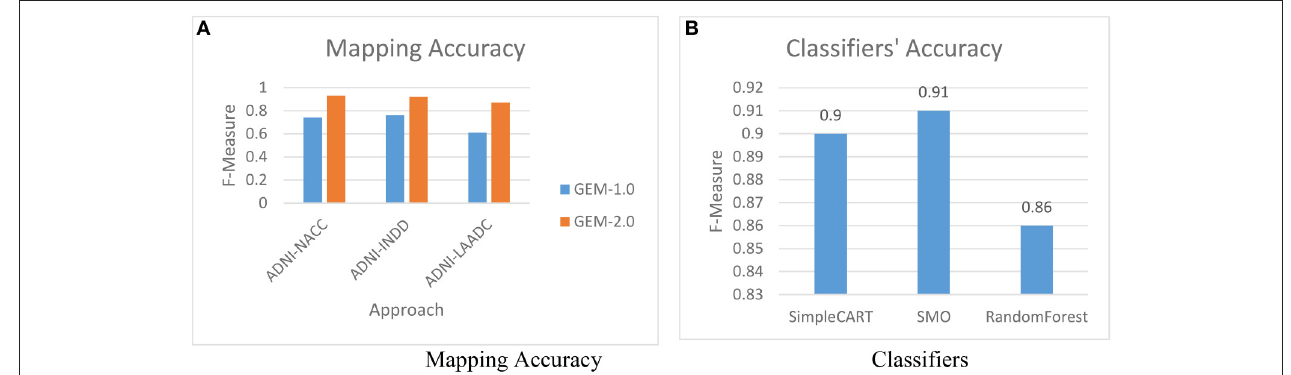
FIGURE 6 | Mapping accuracy. (A) Mapping accuracy, (B) Classifiers.